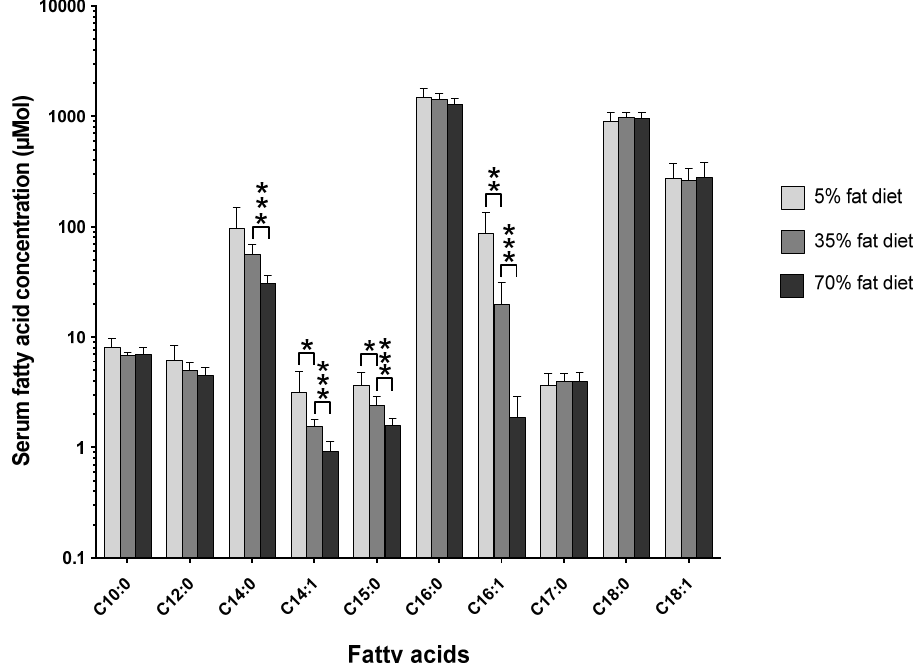
Figure 1. The effect of changing the amount of total-fat within the diet from 5% to 35% to 70% (% energy) on the serum fatty acid concentration ( µ mol) whilst maintaining identical dietary fatty acid compositions across the three diets ( n = 6–7 per group). This is to see if the amount of total-fat within the diet influences the serum fatty acid concentration independent of the actual dietary fatty acid composition. The serum samples were analysed by gas chromatography separation with mass spectrometry detection. The significance of the difference between each group is shown by the p -value star system, where p ≤ 0.05 was considered statistically significant ( p < 0.05 = *, p < 0.01 = **, p < 0.001 = ***). Error bars represent ± standard error of the mean.